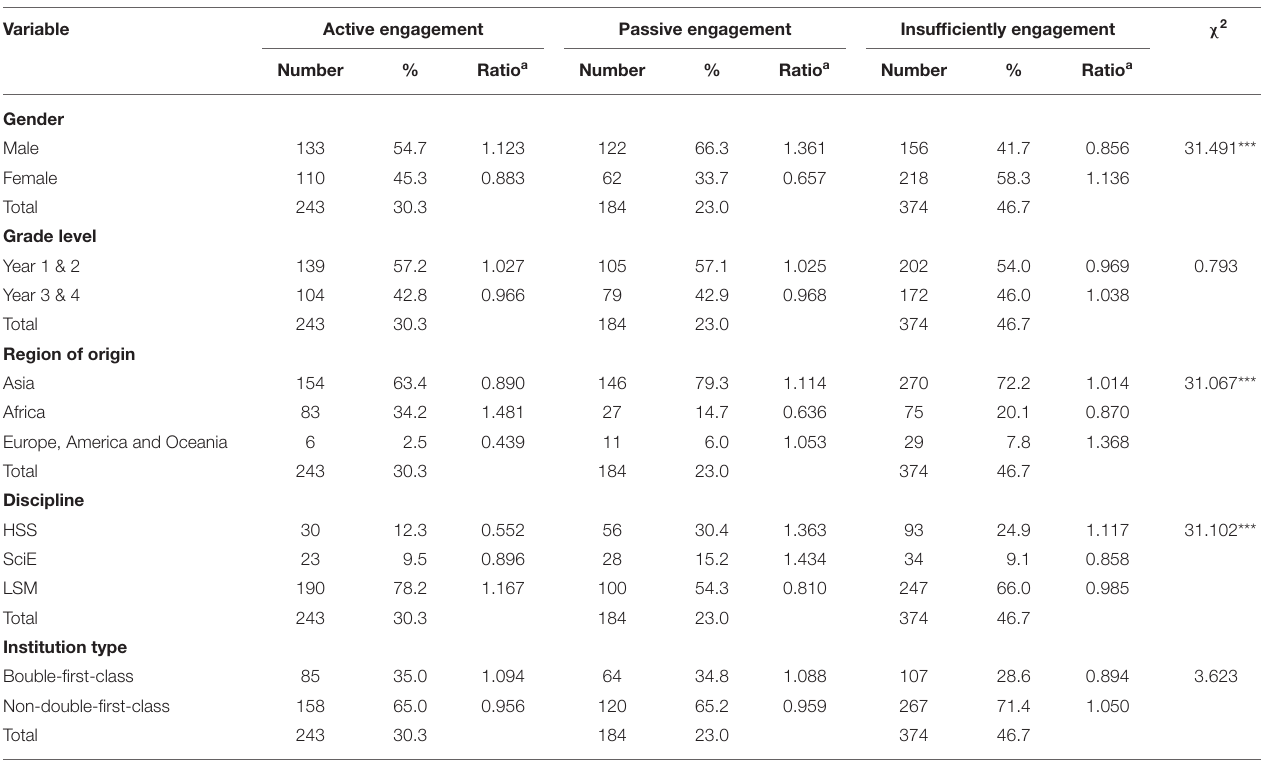
TABLE 7 | Distribution across the three types of engagement. Variable Active